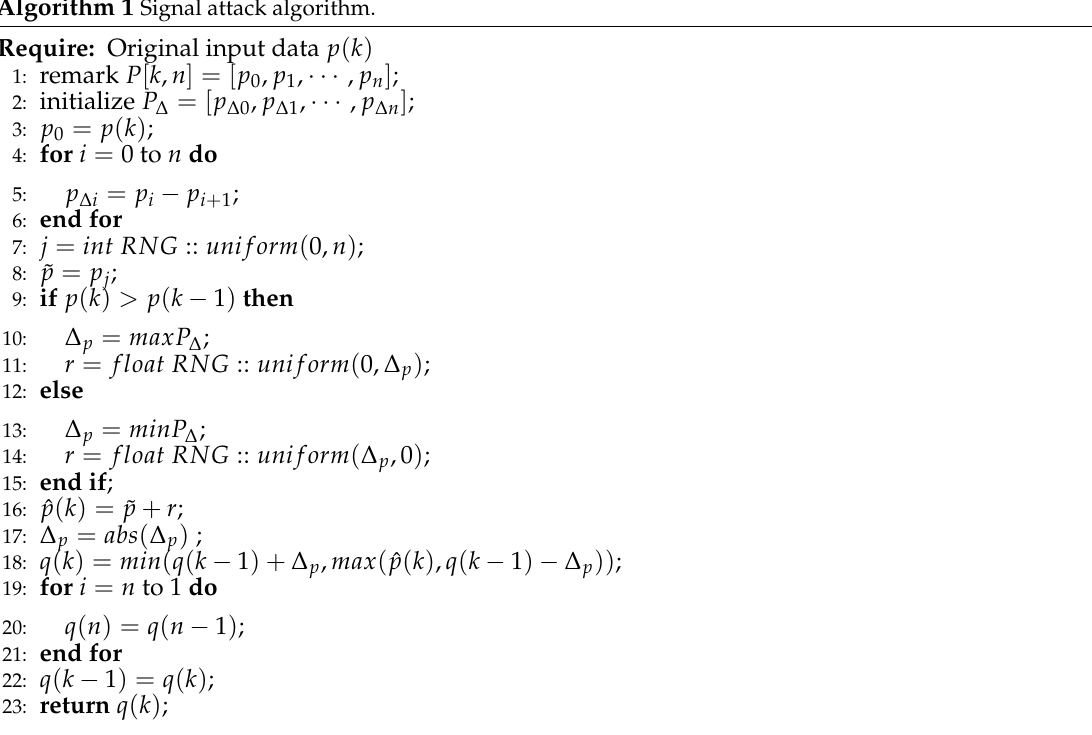
Algorithm 1 Signal attack